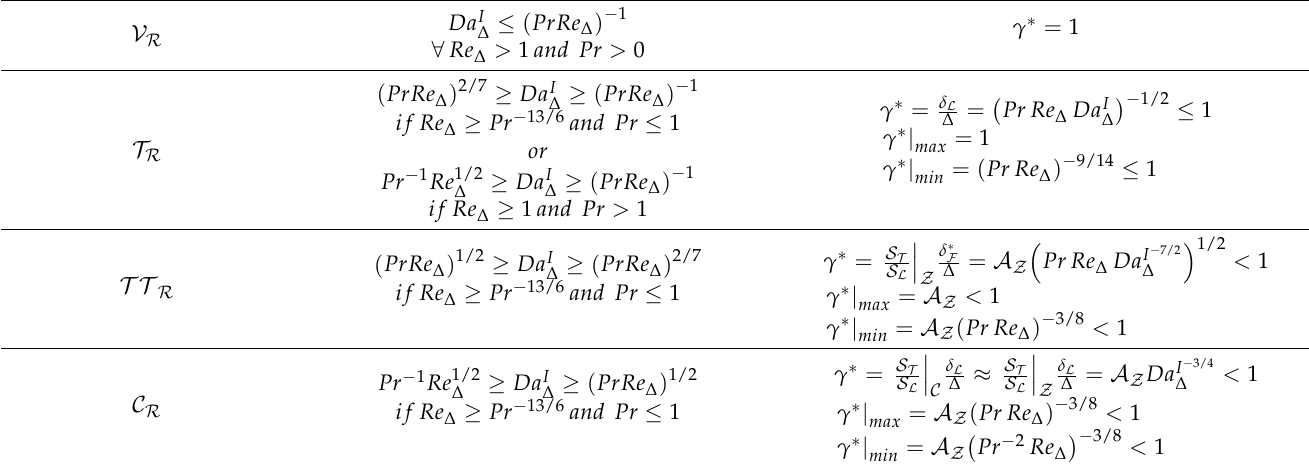
Table 4. Summary of the LTSM combustion regimes shown in Figure 5, their existence conditions, and the related expressions for the reacting fine structures volume γ ∗